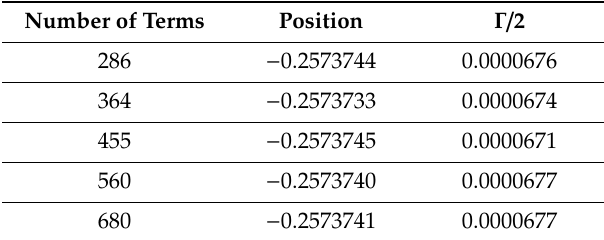
Table 17. Position and width of the resonance in Rydberg units.